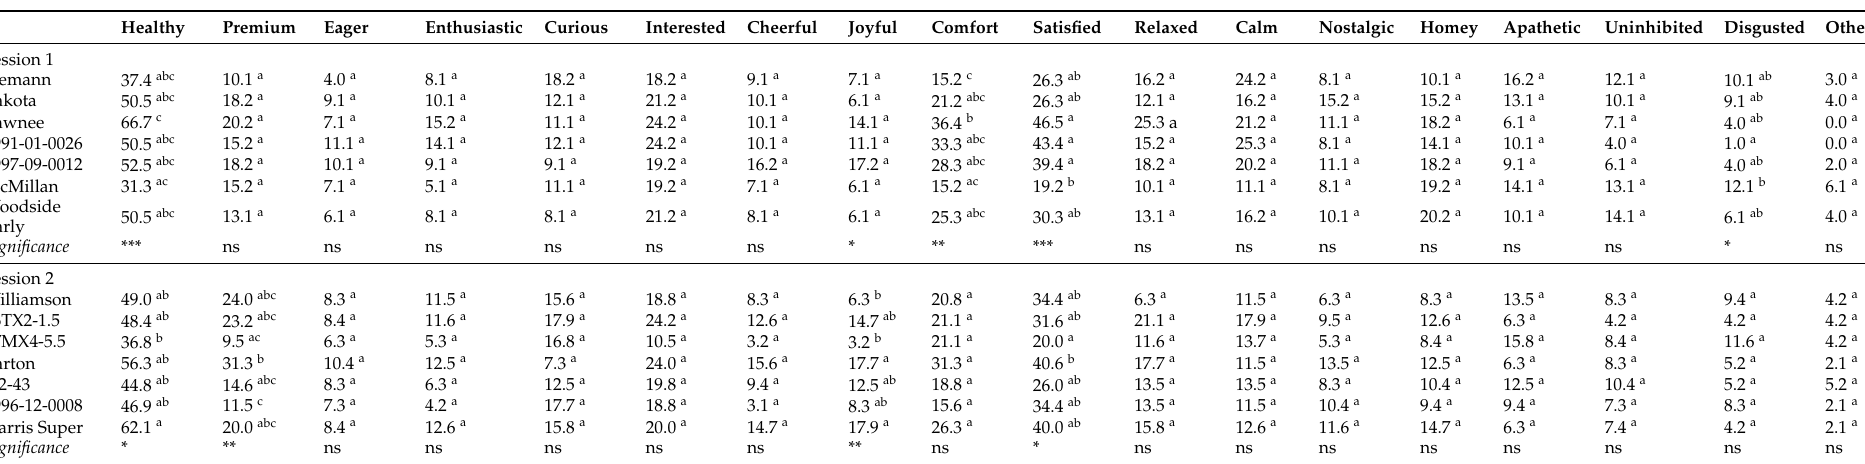
Table 3. Frequency (ticked responses, %) of each emotional term for 14 pecan samples using a CATA (check-all-that-apply) question